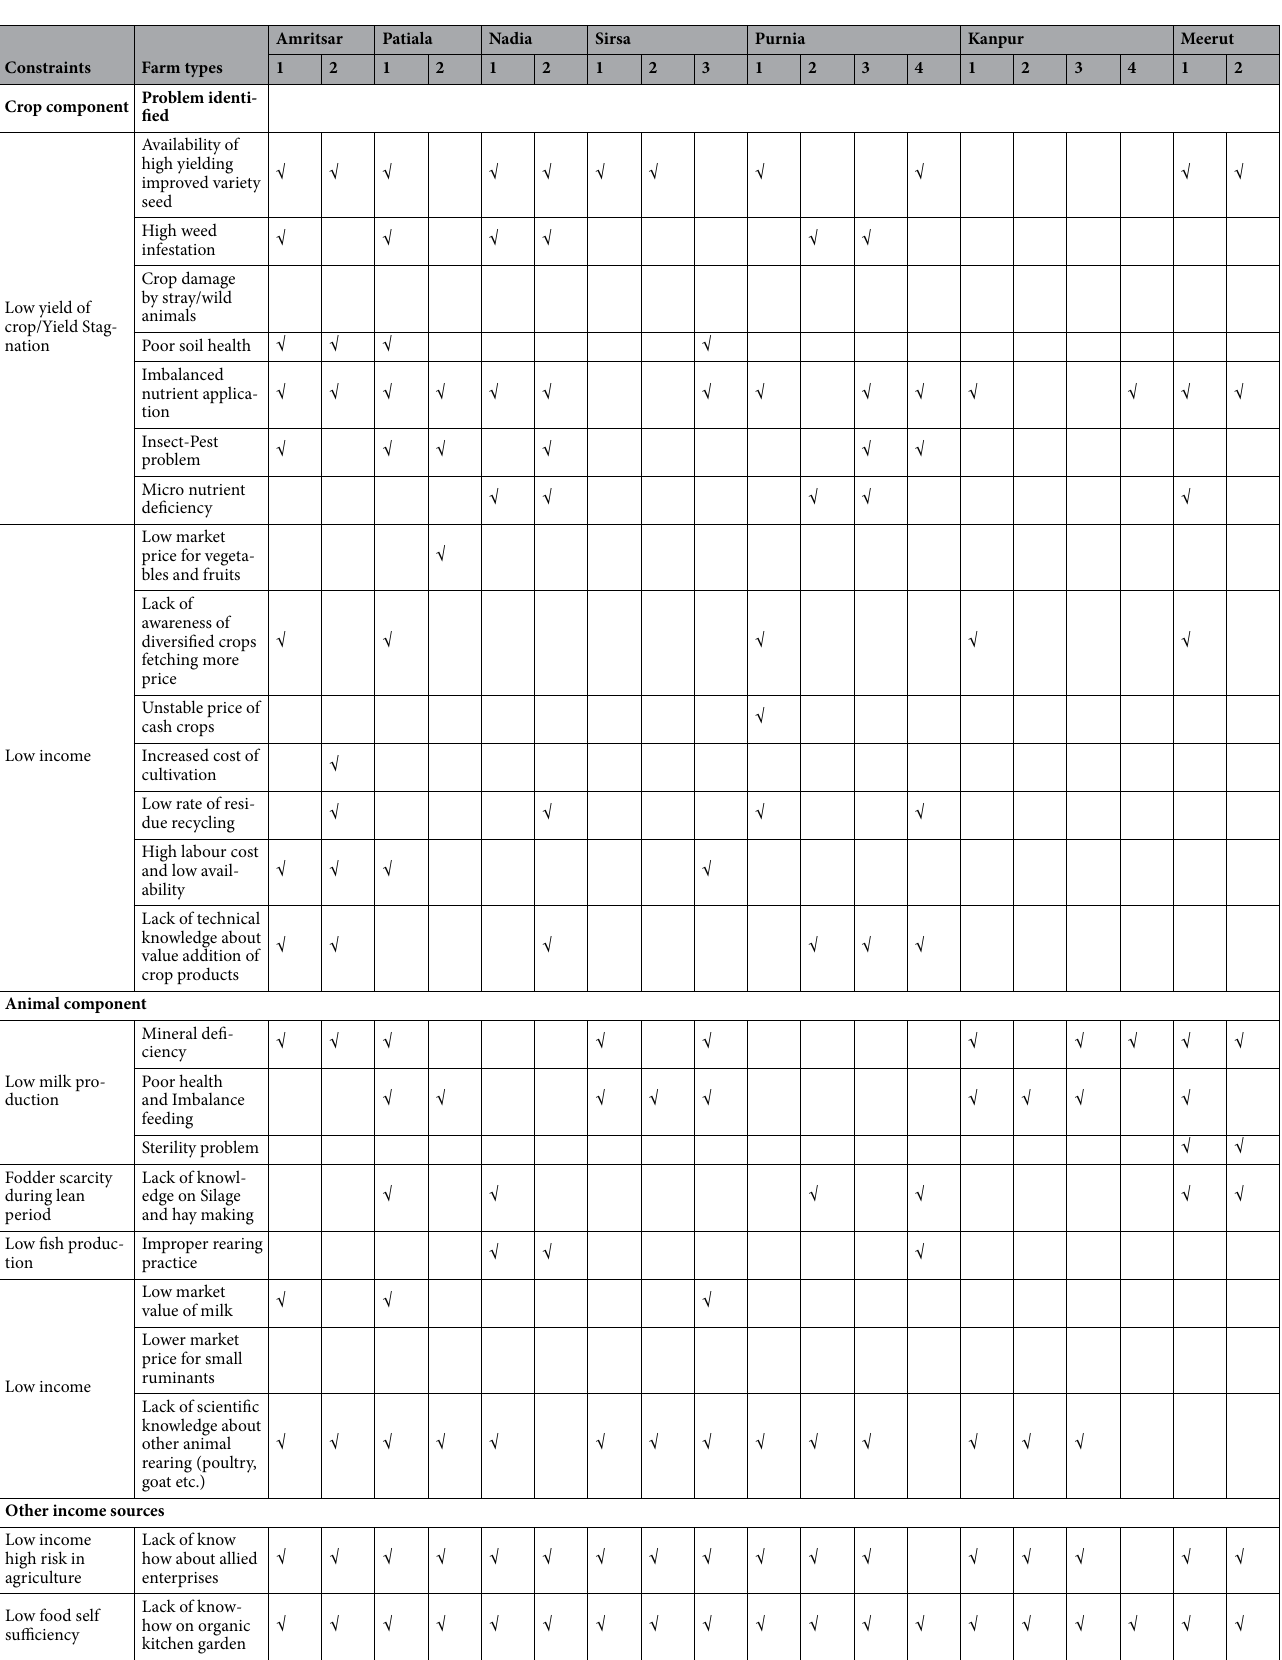
Table 3. Constraints and problem identified (farm type wise) in studied districts falling under IGP (Based on